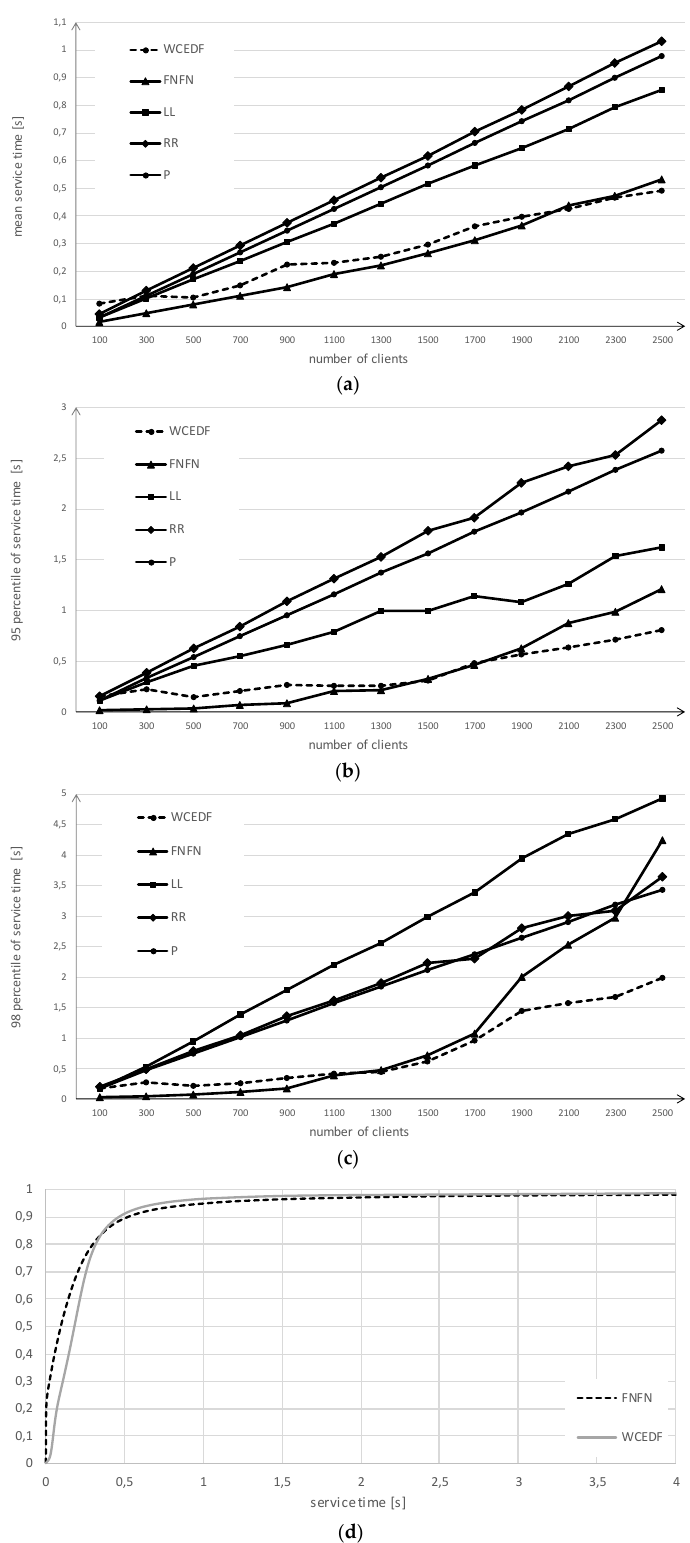
Figure 6. Results of experiments for t max = 0.5 s. ( a ) Mean service time in load function (number of clients), ( b ) the 95 percentile of service time in load function, ( c ) the 98 percentile of service time in load function, and ( d ) the cumulative distribution of service time for a number of clients equal to 2300. As it can be seen in Figure 6, when the load of the system was low, the mean response time, the 95 percentile, and the 98 percentile were the lowest for the FNFN configuration. The FNFN configuration was very effective in minimizing HTTP request service times.